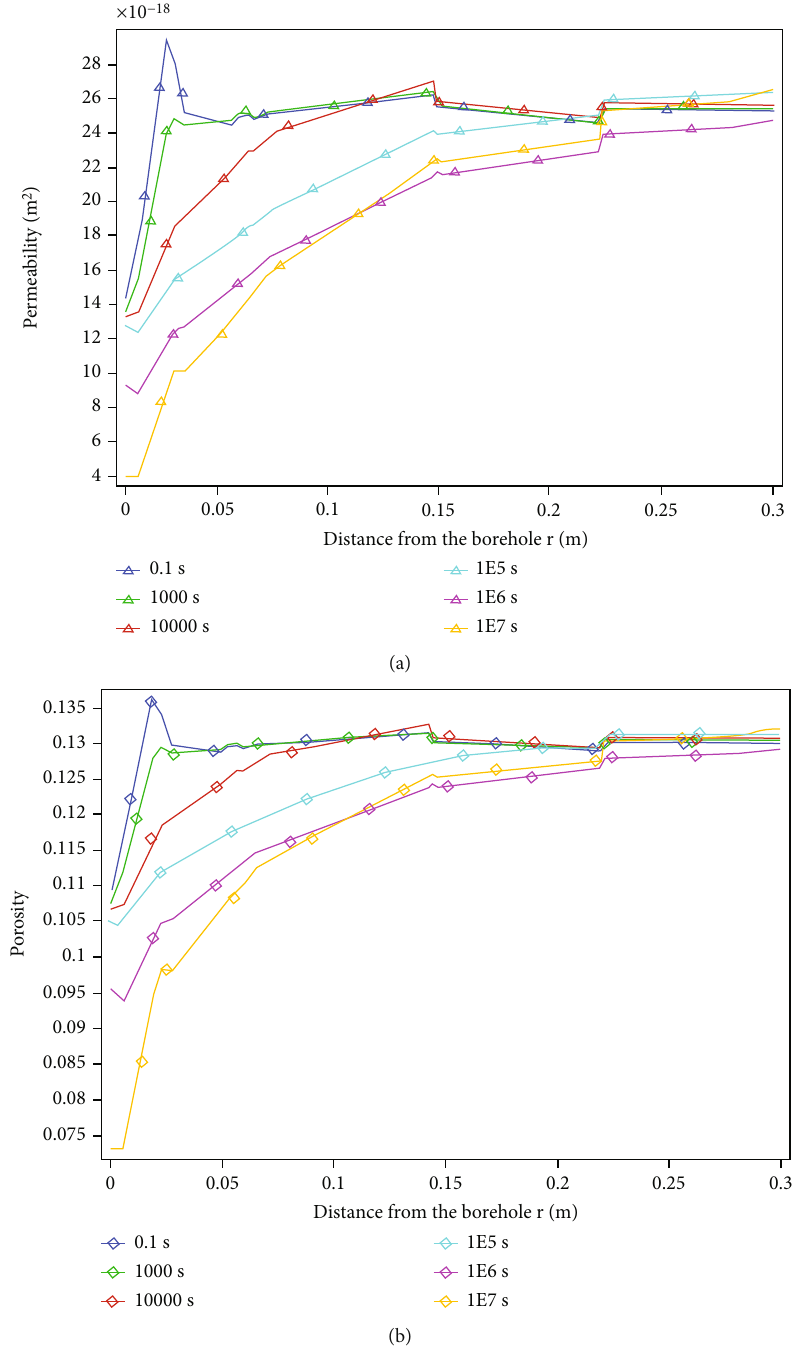
Figure 17: Permeability (a) and porosity (b) in the m = 7 coal rock during CBM